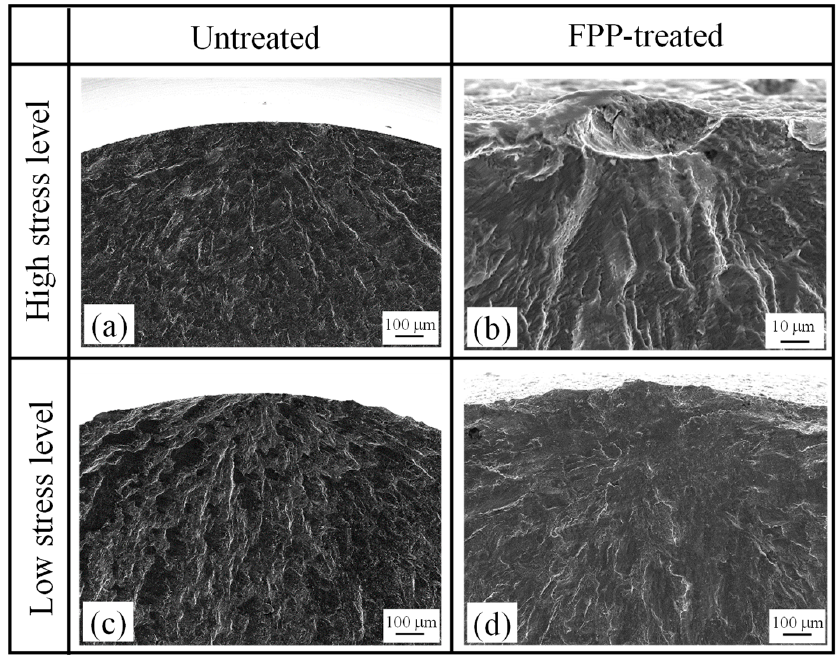
Figure 10. SEM micrographs showing crack initiation site of untreated specimen and FPP-treated specimen failing at ( a ), ( b ) high ( σ a = 800 MPa) and ( c ), ( d ) low ( σ a = 600 MPa) stress levels.